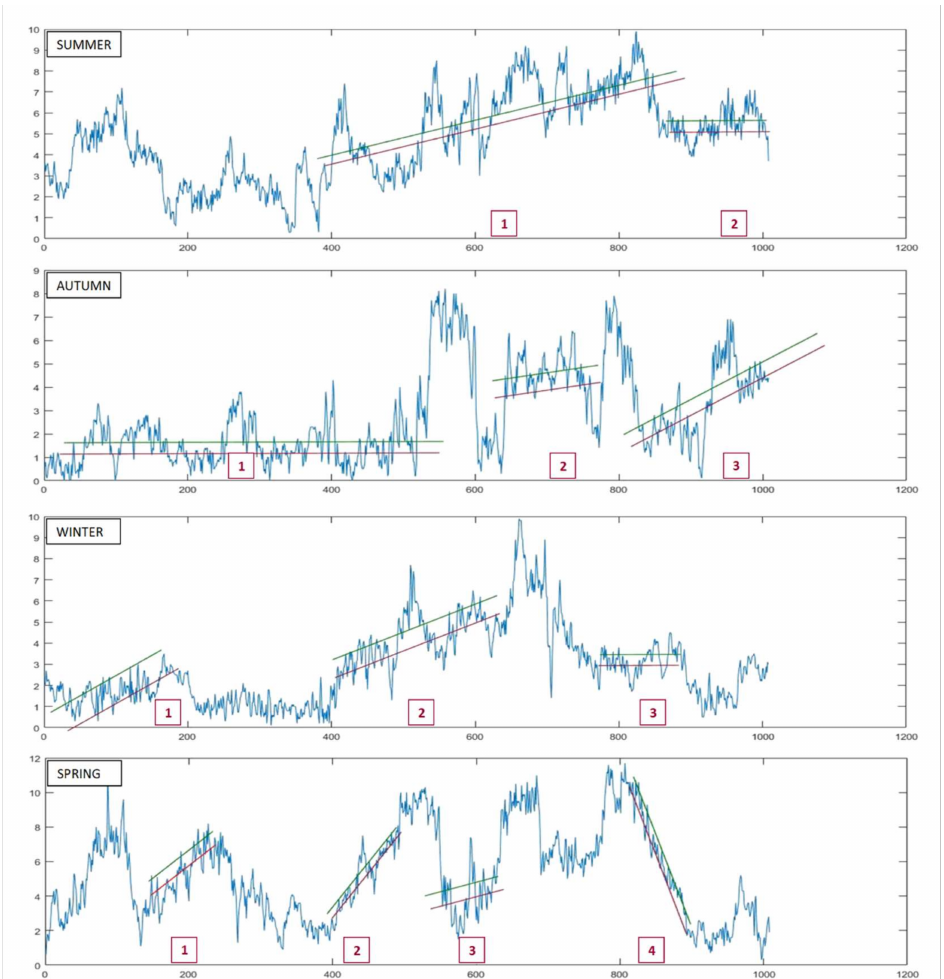
Figure 2. Wind speed data series for Los Montes del Cierzo (10 min resolution, for the first weeks of August 2016, November 2016, January 2017 and April 2017, height of 10 metres above the ground) with some significant examples of trending